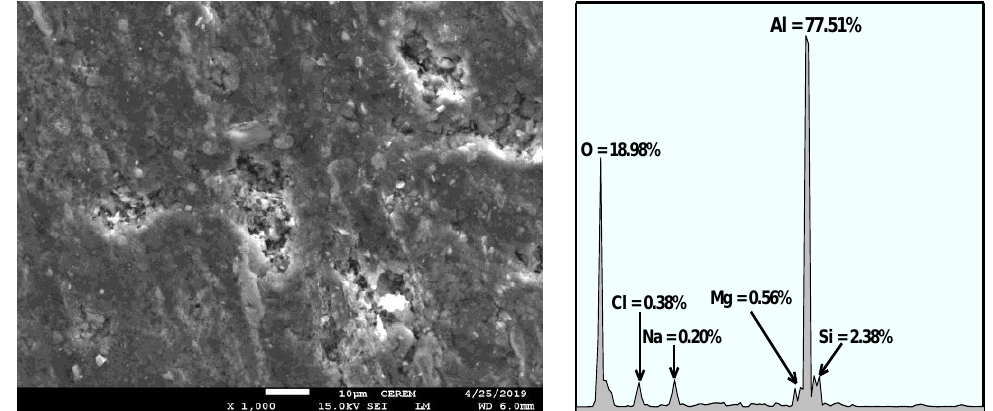
Figure 8. SEM micrograph and EDX profile analysis taken for the as received alloy after its immersion for 24 h in NaCl solution and applying −680 mV for 40 min.